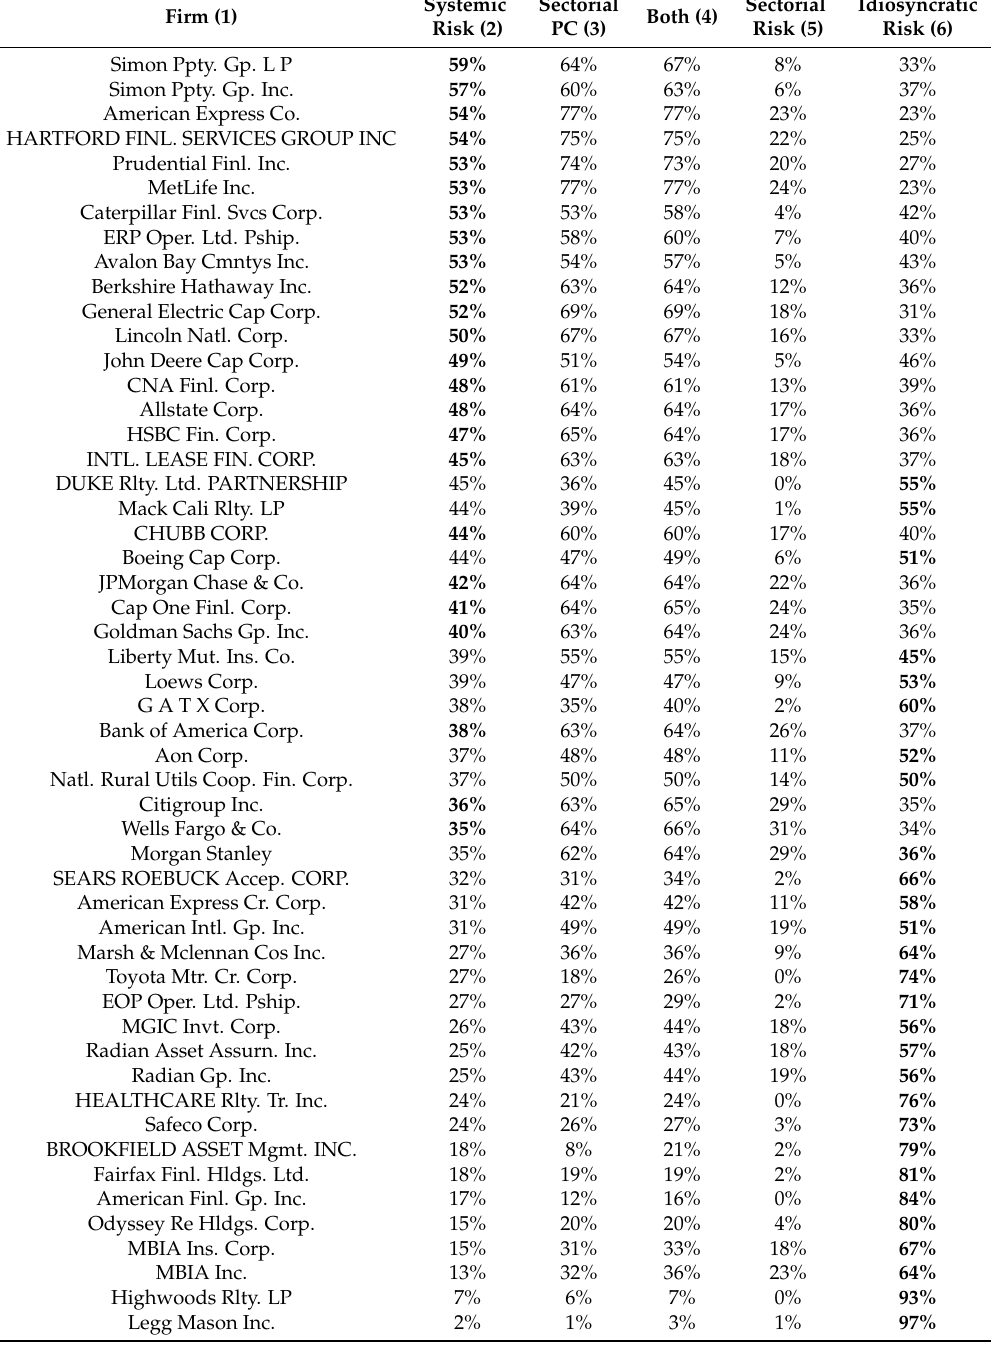
Table 12. Credit risk decomposition for the North American financial sector. Systemic Sectorial Sectorial Firm (1) Simon Ppty. Gp. L